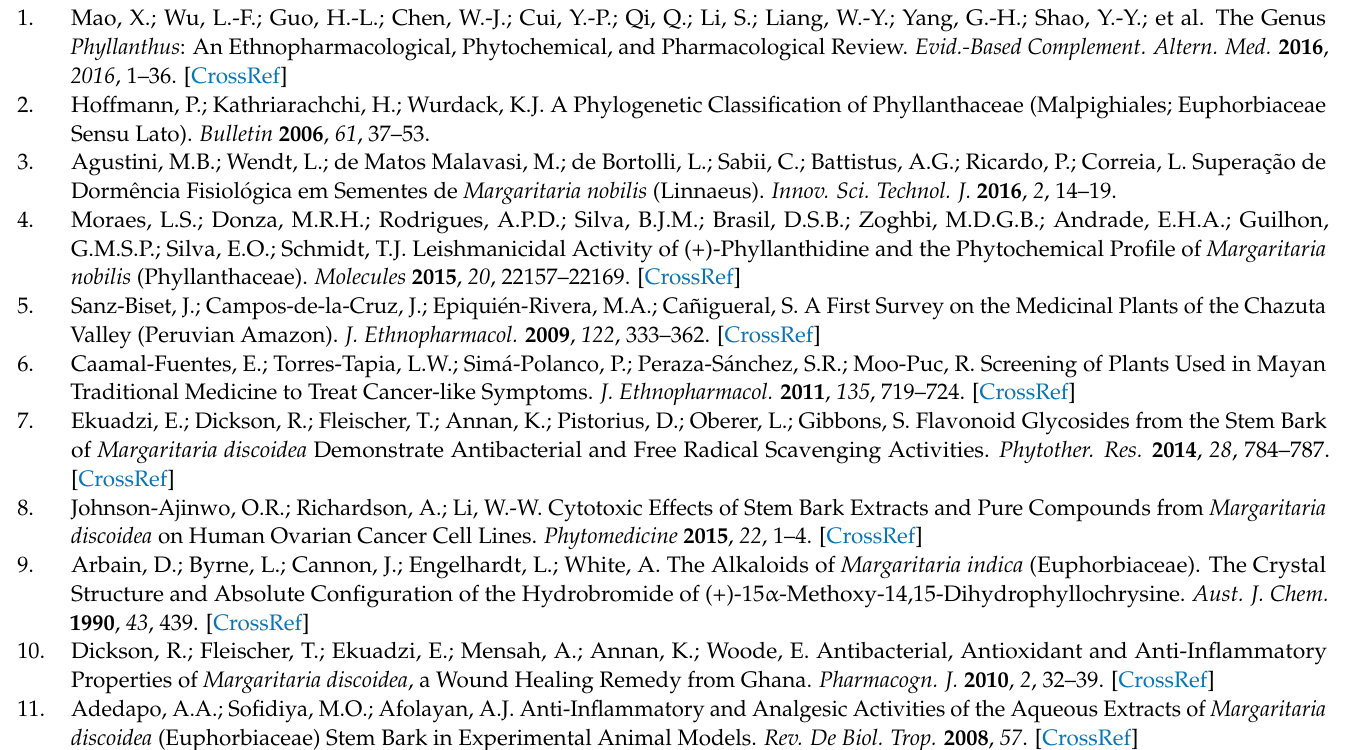
leaf extract; Figure S3. Proposed structures for annotated metabolites in the ethanolic extract of Margaritaria nobilis leaves; Figure S4. General fragmentation scheme and MS/MS spectra of O - glycosylated kaempferol derivatives; Figure S5. O -glycosylated quercetin derivatives MS/MS spectra; Figure S6. MS/MS spectra of hydrolysable tannins annotated in silico; Table S2. In-house database of compounds reported in the genus Margaritaria